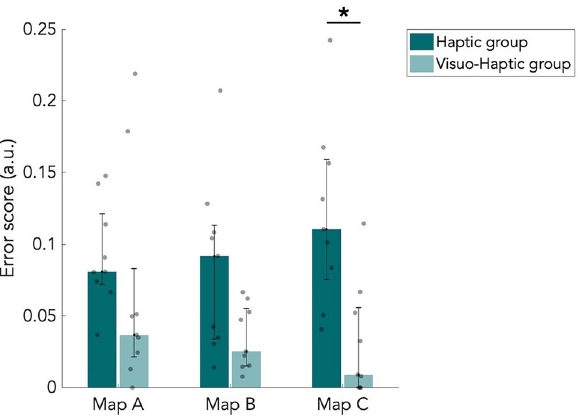
Figure 6. Error scores of the item placement task. Median error score of placed items, corrected for the maximum error possible. Results are shown for all three maps and both the haptic (n = 9) and visuo-haptic group (n = 9). Error bars indicate the 25th and 75th percentiles. Grey dots are individual data points. * p < 0.05, corrected for multiple comparisons.